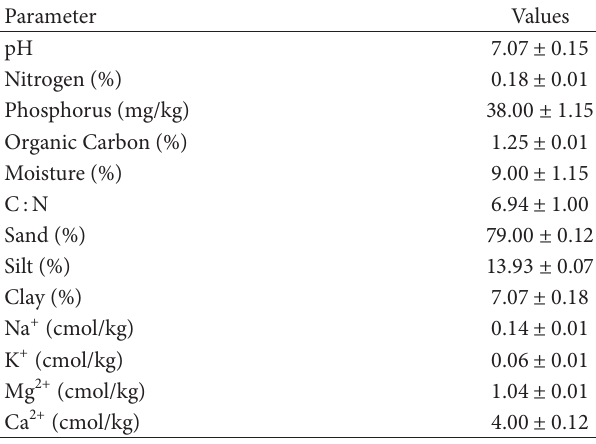
Table 2: Physicochemical properties of Pb polluted soil after